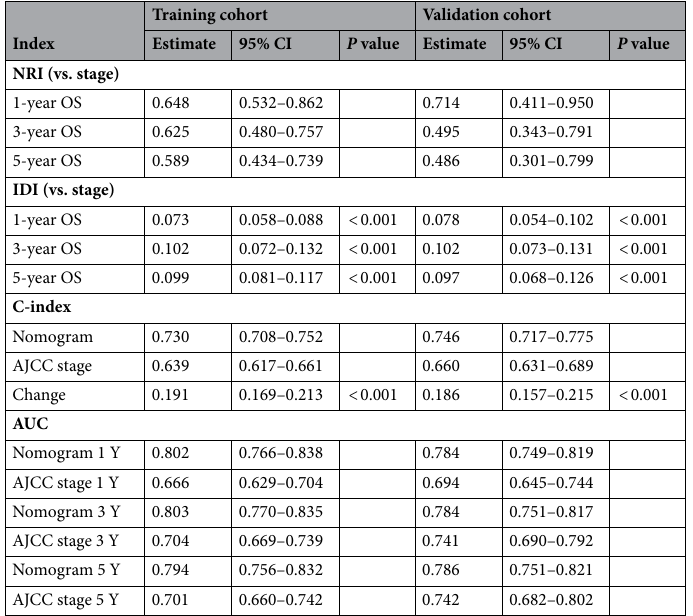
Table 3. NRI, IDI, C-index, and AUC of the nomogram and the AJCC 8th edition TNM-staging system in survival prediction for NM-GBA patients. NRI net reclassification improvement, IDI integrated discrimination improvement, CI confidence interval, OS overall survival, AJCC American Joint Committee on Cancer, AUC area under the curve, Y